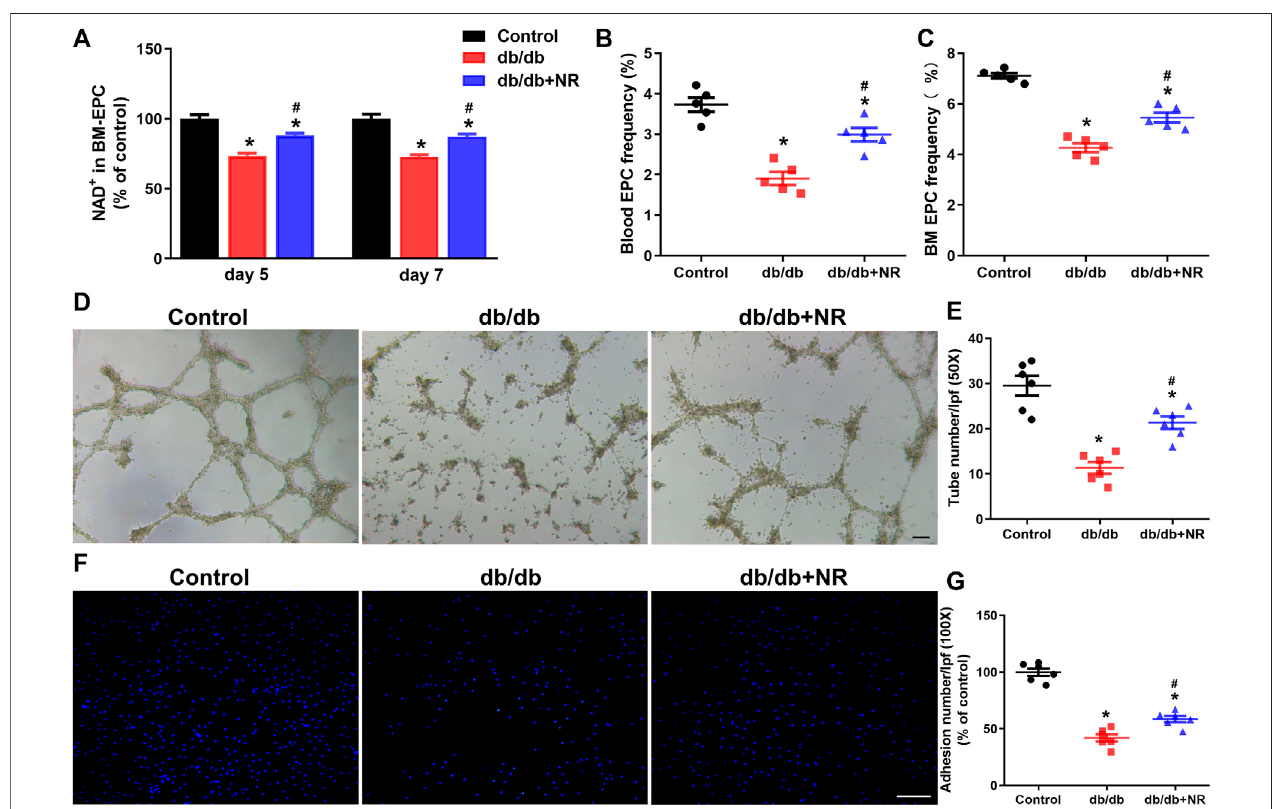
FIGURE3| EffectsofNRsupplementonEPCnumberandBM-EPCfunctionin db/db mice. (A) NADconcentrationsinculturedBM-EPCs(day5andday7 invitro ) isolated from mice. Blood EPC (B) and BM EPC (C) frequency innormal control and db/db mice. Tube formation (D,E) and cell adhesion (F,G) of BM EPC isolated from normal control and db/db mice. D: 50 × ; scale bar, 100 μ m; F: 100 × ; scale bar, 100 μ m. Values are mean ± SEM (A, B, C: n (cid:2) 5; D, E, F, G: n (cid:2) 6). * P < 0.05 vs. Control; # P < 0.05 vs. db/db . BM, bone marrow; BM-EPC, bone marrow – derived endothelial precursor